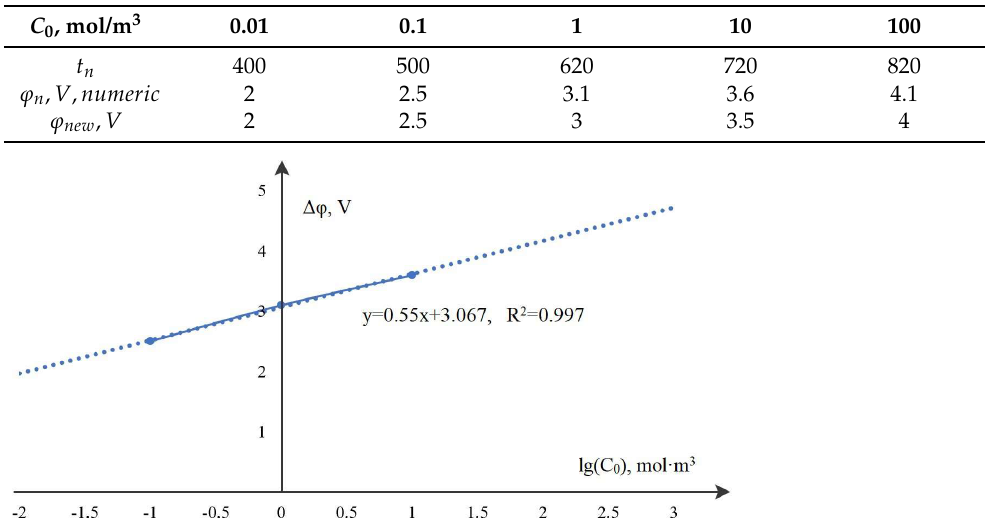
Figure 7. Dependence of the jump in the breakdown start potential ϕ n for a KCl solution on the logarithm of the initial concentration C 0 at a channel width of 1